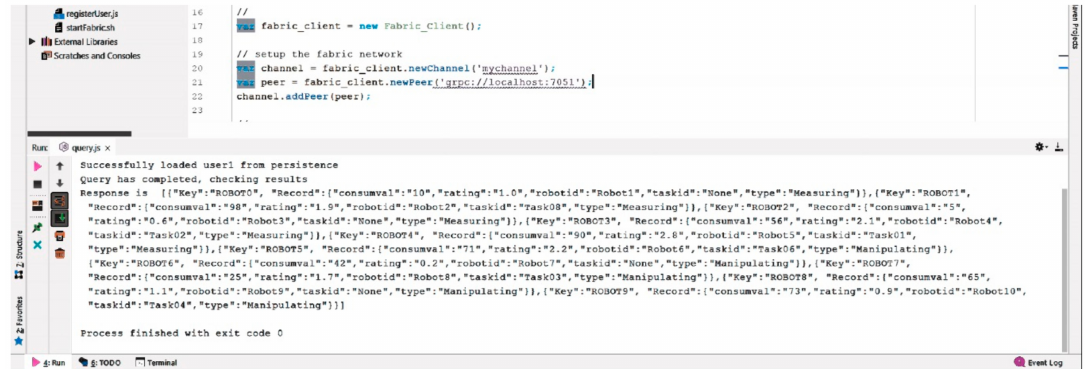
Figure 11. System log snapshot from the Hyperledger Fabric